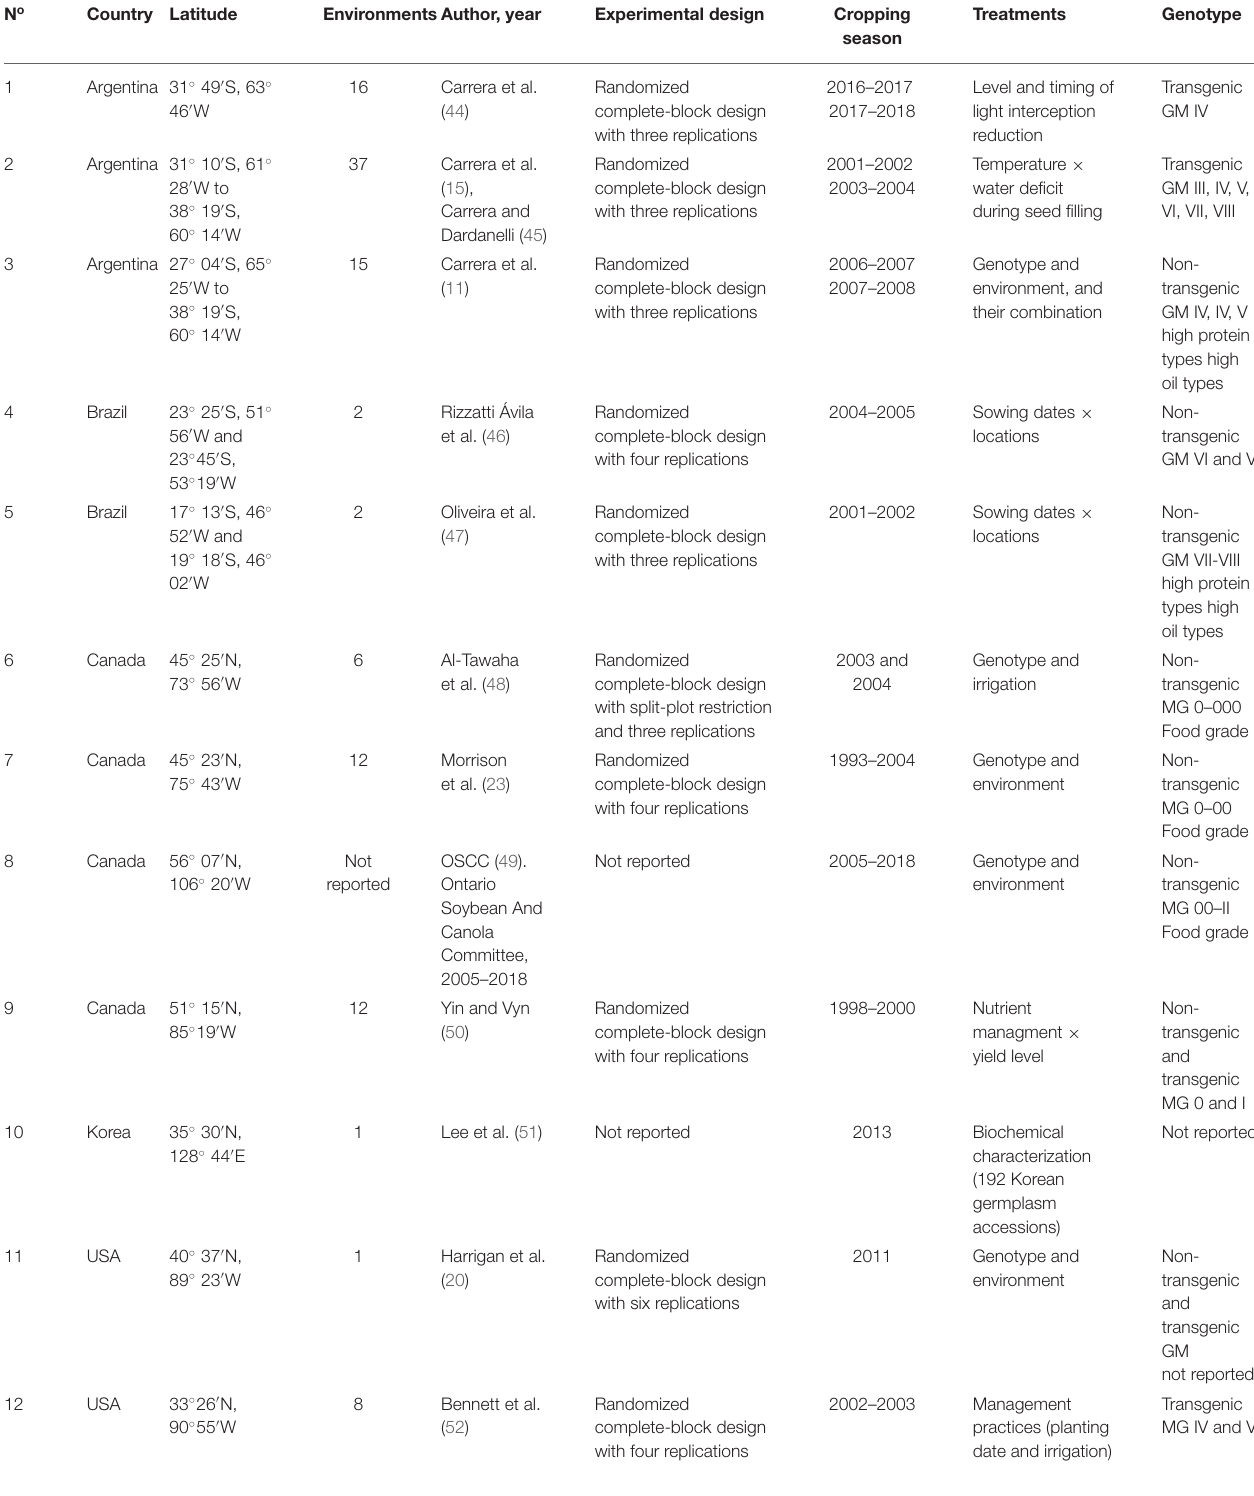
TABLE 1 | Number of study, country, latitude, number of involved environments defined as crop year, location, and sowing date combinations, author and year of publication, experimental conditions and design, cropping season, treatments evaluated, and genotype type for each study included in the soybean seed protein and isoflavone meta-data